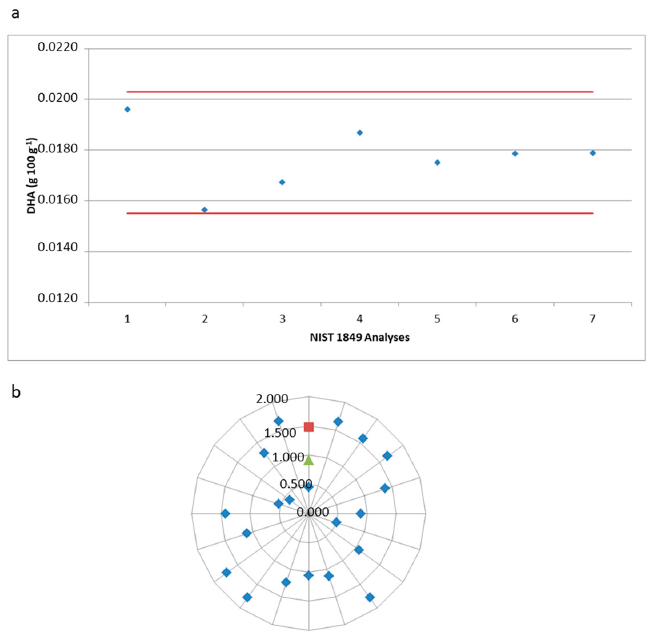
Figure 4. Reproducibility and precision of the optimized methodology for docosahexaenoic acid